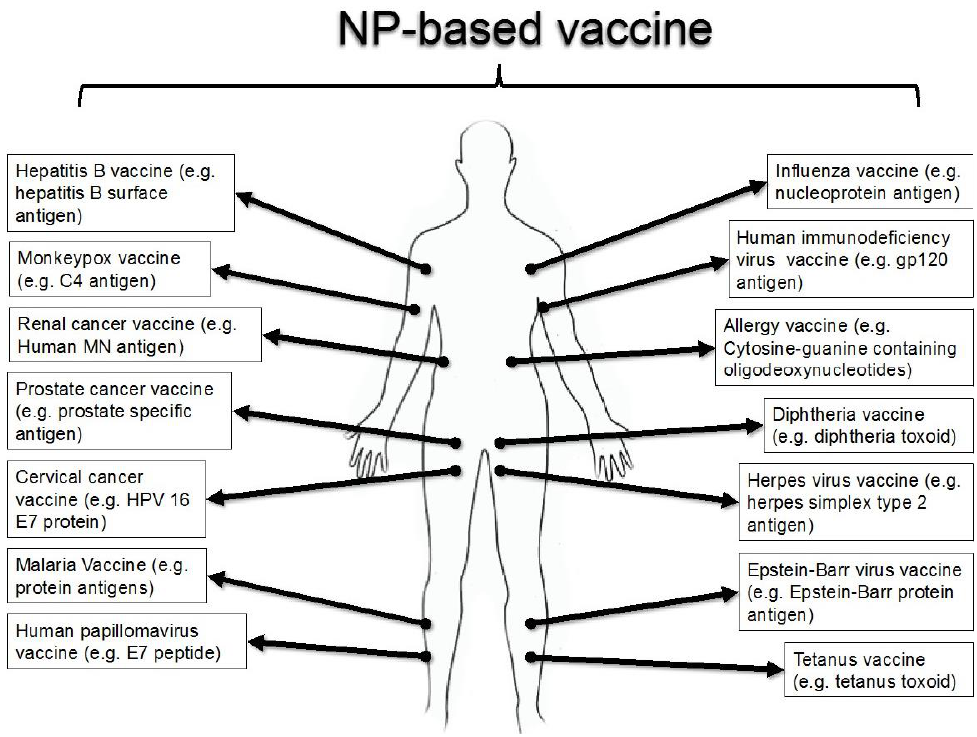
Figure 1. Overview of possible vaccines that can be generated using NPs.